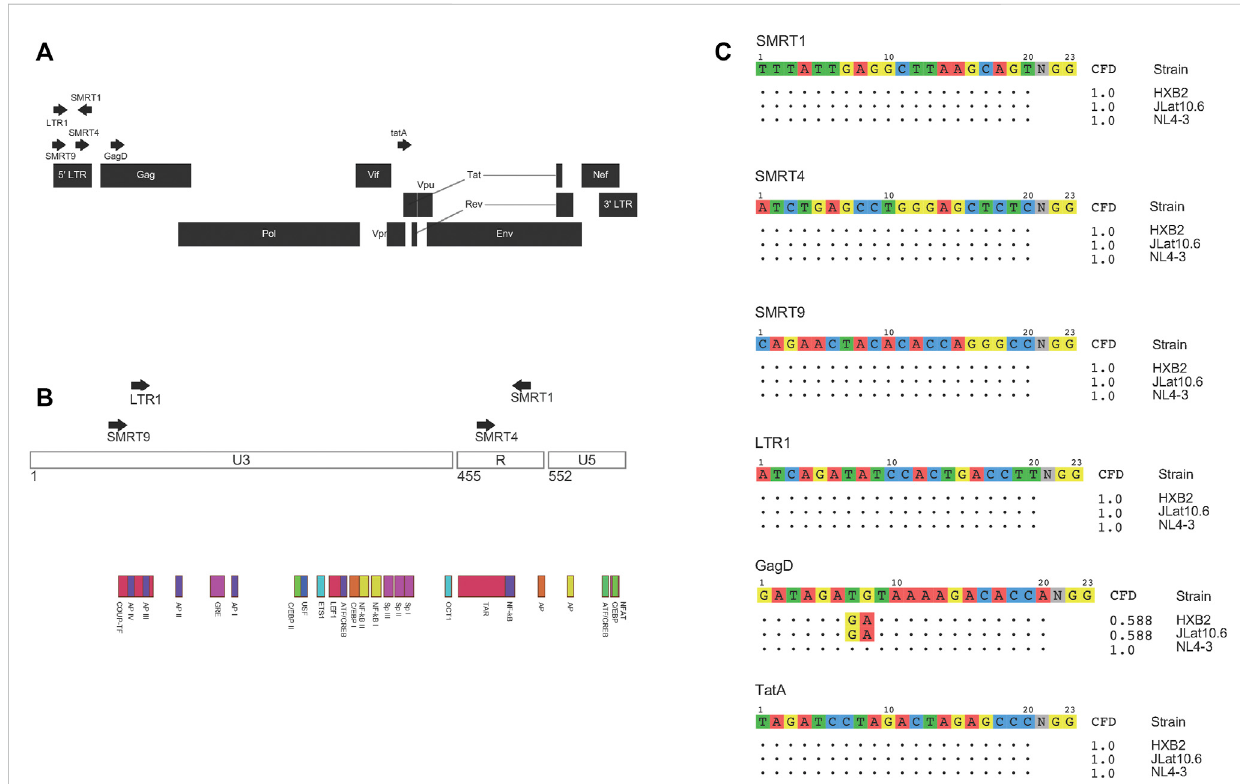
FIGURE 1 gRNAs used and their match to NL4-3, R7, and HXB2 HIV-1 strains. Schematic representation of where the gRNAs used in this study targeted the HIV-1genome (A) .Magni fi edviewoftheHIV-1LTRandwheredifferentgRNAstargetinsidetheLTR (B) .AllgRNAswerethenalignedtodifferentstrainsof HIV-1. Both NL4-3 and R7 were used in this study, whileHXB2 is acommonly referred to HIV-1 genome. Based on where the mismatches were between thegRNAandtargetsequenceaCFDscorewascalculatedbasedonapreviouslypublishedpenaltymatrix.CFDscoresrangefrom0to1,0beingno predicted binding and 1 being a high probability of binding (C)